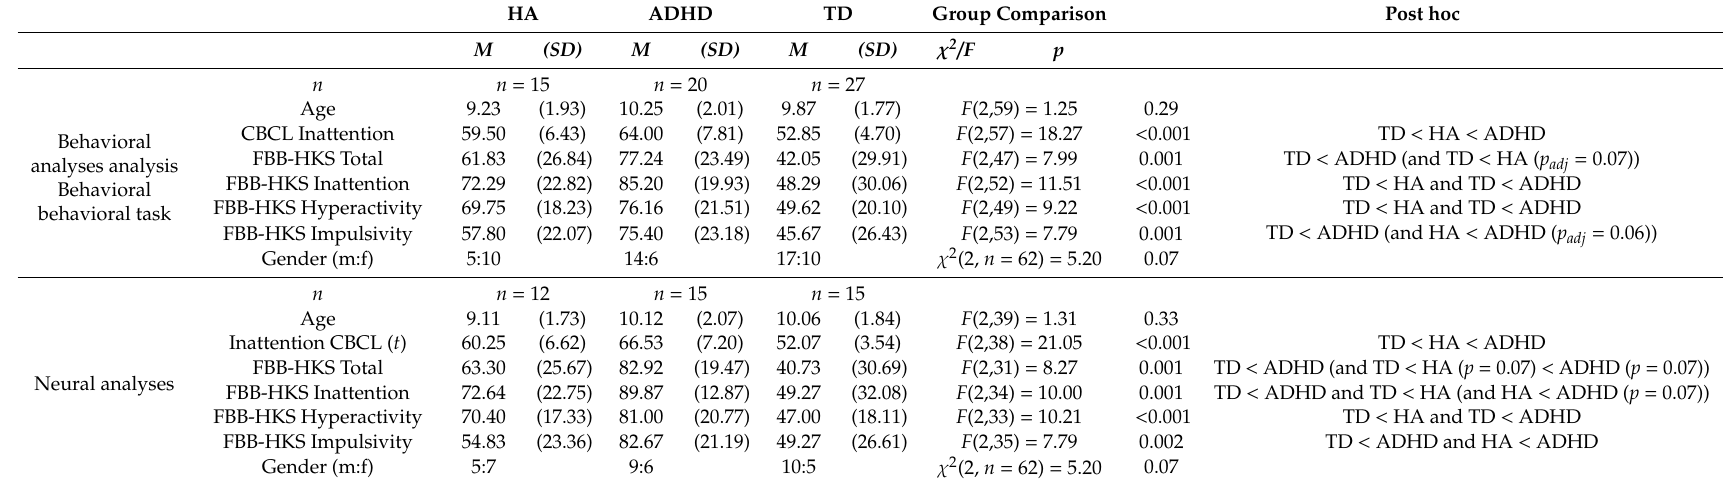
Table 1. Demographic data for the behavioral and neural